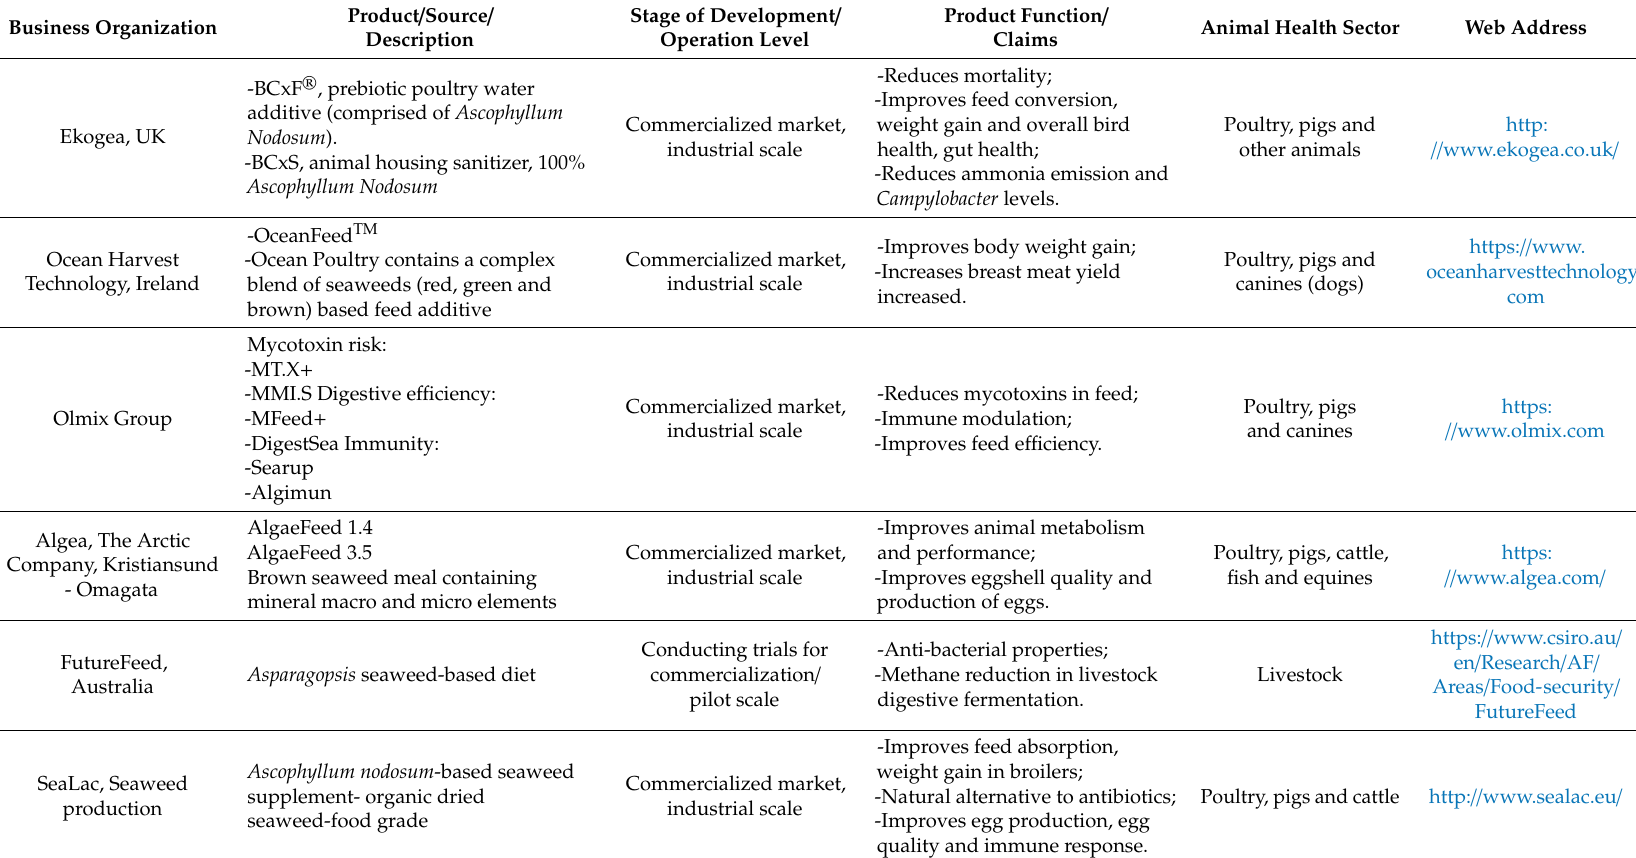
Table 3. Summary of major seaweed companies supplying poultry feed and